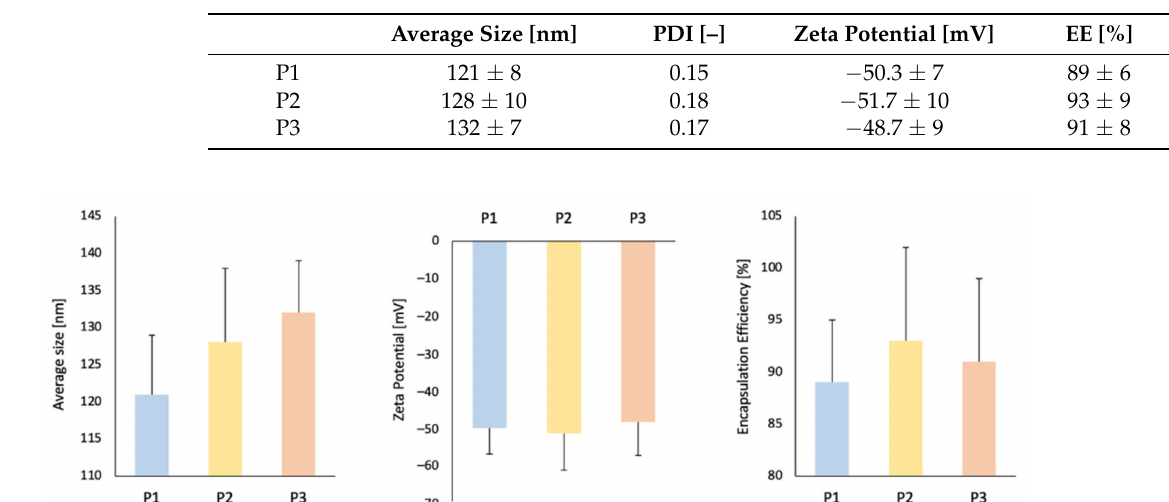
Table 1. Average size ± SD, polydispersity index (PDI), zeta potential ± SD and encapsulation efficiency ± SD (EE).